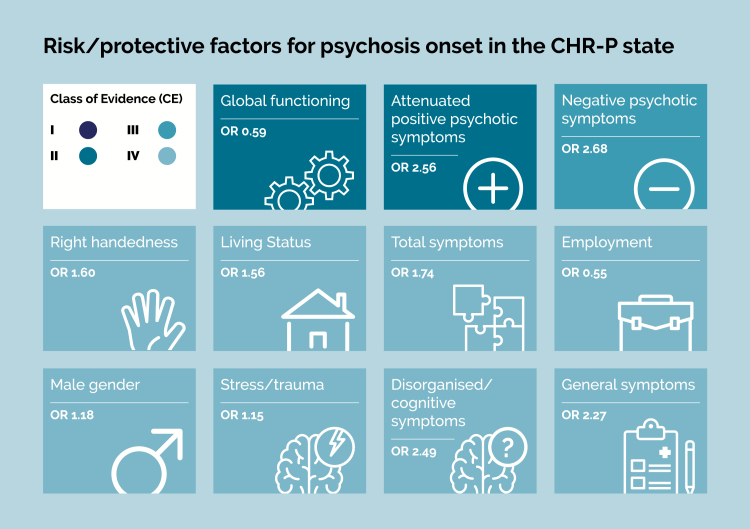
Graphical summary of risk/protective factors for psychosis onset in the CHR-P state. No factors met criteria for a convincing level of evidence (class I), two factors for a highly suggestive level of evidence (class II), one factor for a suggestive level of evidence (class III) and eight for a weak level of evidence (class IV).